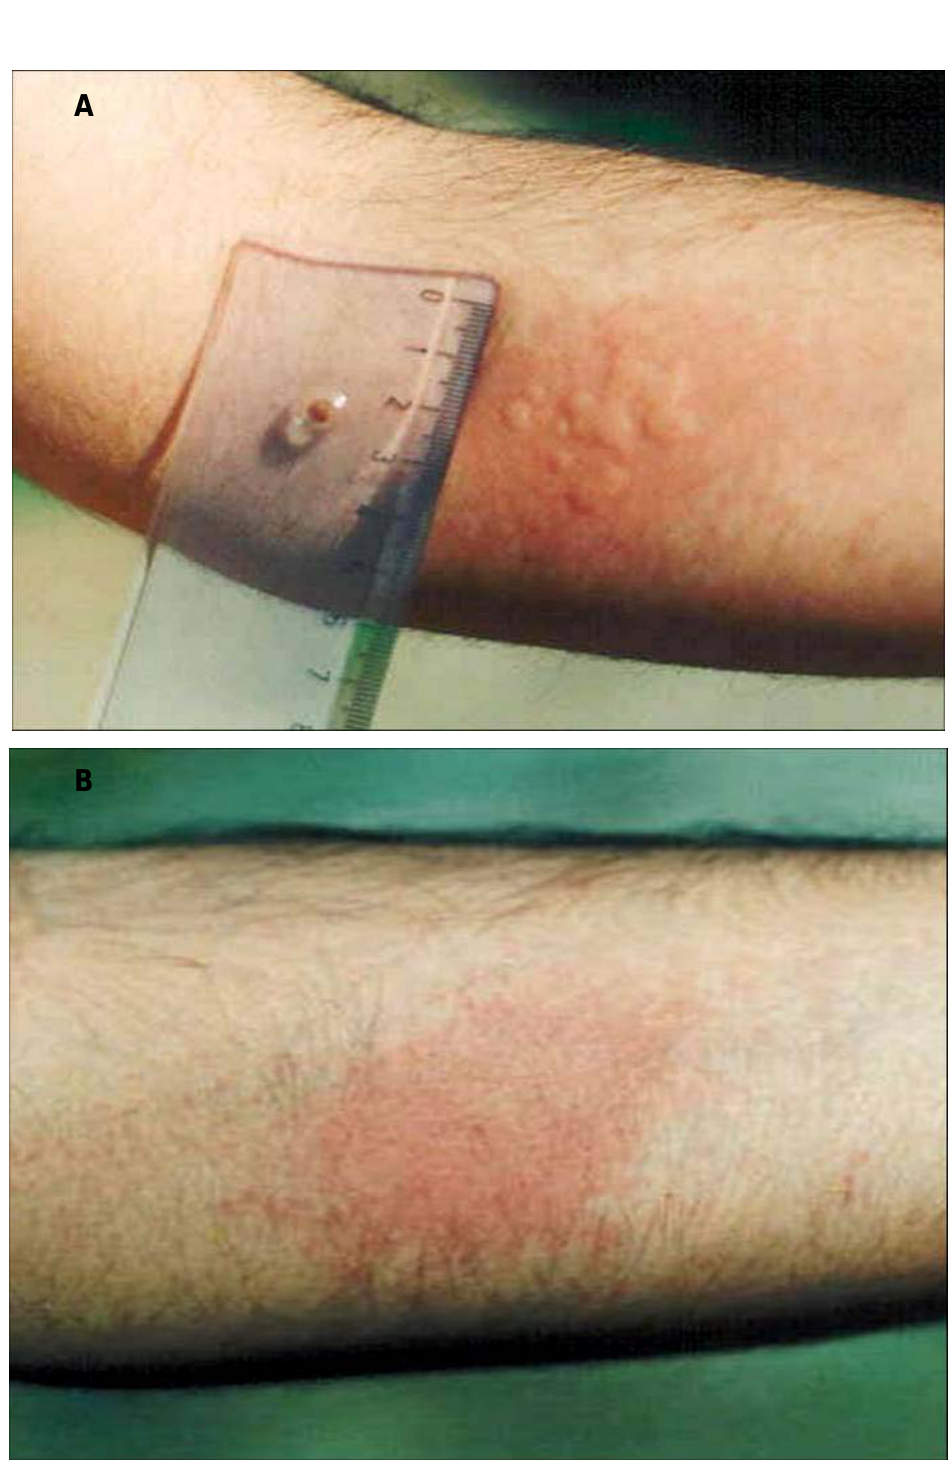
Figure 3. Clinical symptoms after P. sennaarensis sting: ( A ) papules are the first symptoms and are followed by ( B ) erythema in less than 15